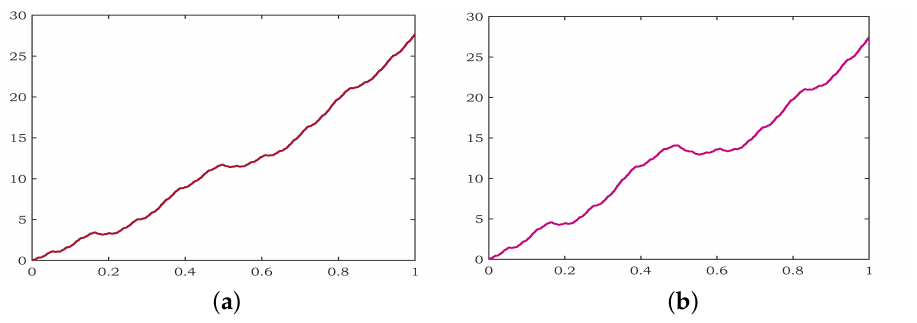
Figure 2. The RL fractional integral: ( a ) I µ ( s ) f 1 with variable order µ ( s ) = 0.5, ( b ) I µ ( s ) f 2 with order µ ( s ) =